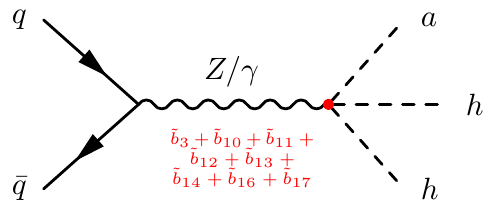
Fig. 10 Maindiagramscontributingtomono-Higgs( left )anddi-Higgs ( right ) production in association with an ALP. The non-linear param- eters entering each vertex are reported in the figure. Note that for the case of mono-Higgs, the contributions of ˜ a 2 D and ˜ a 3 are phenomeno-